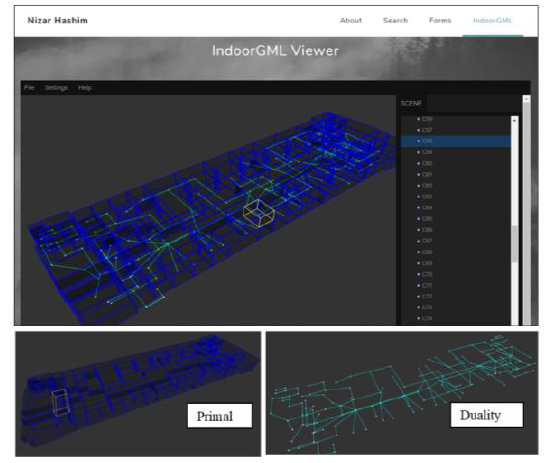
Figure 9. IndoorGML viewer